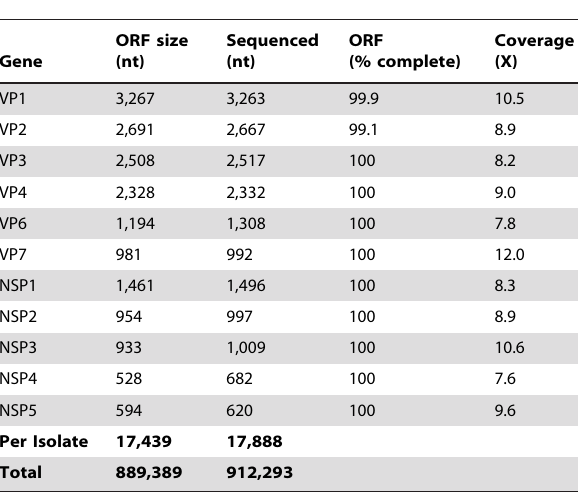
Table 2. Sequencing Results for Fifty-one Complete Genomes of Human G3P[8]